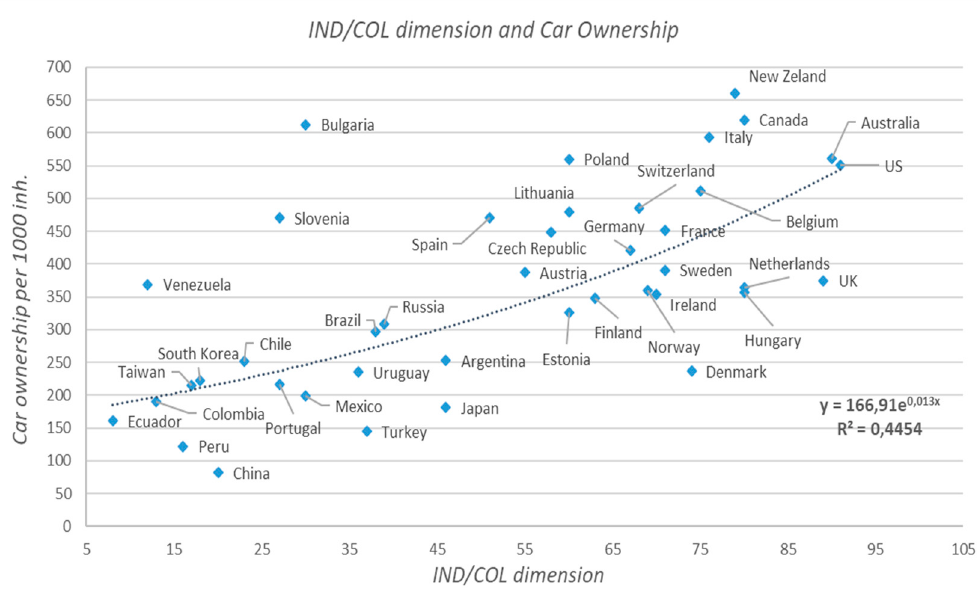
Figure 4. Car ownership over individualism-collectivism dimension.